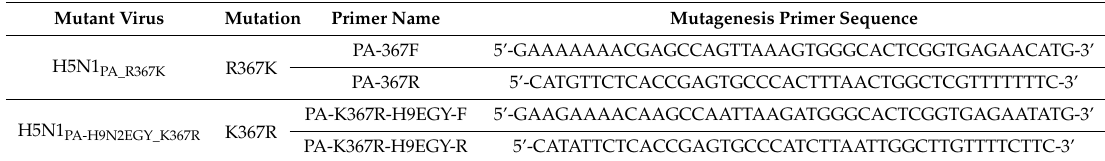
Table 1. Site directed mutagenesis